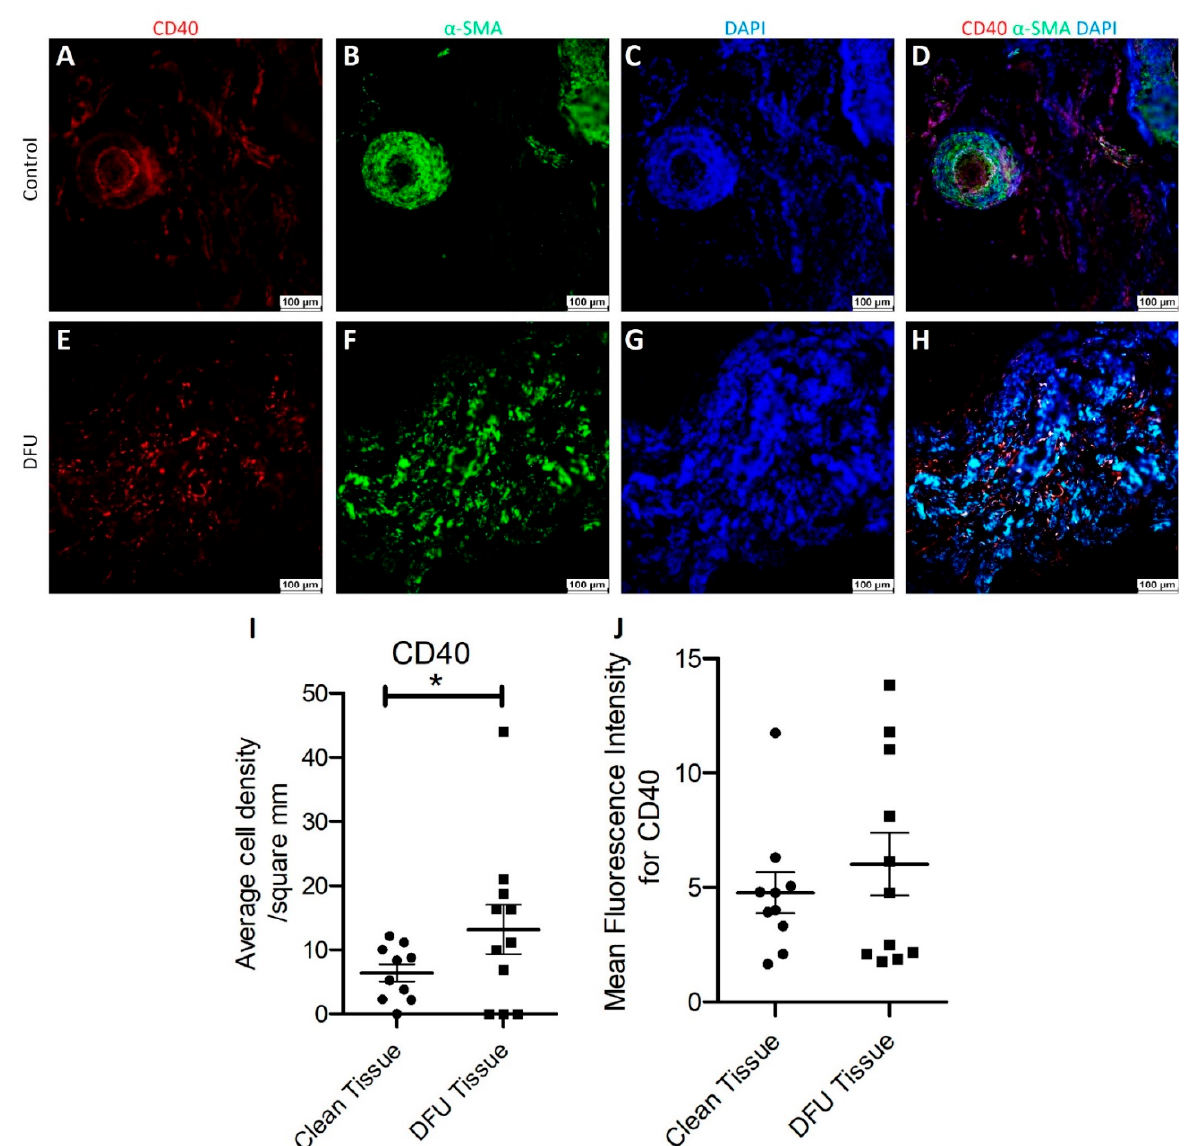
Figure 7. Dual immunofluorescence for alpha-smooth muscle actin ( α -SMA) and CD40 in clean and diabetic foot ulcer (DFU) tissues. CD40 ( A , E ), α -SMA ( B , F ), DAPI ( C , G ), merged images ( D , H ), average cell density/mm 2 ( I ), and mean fluorescence intensity for CD40 ( J ). All data are presented as mean ± SEM ( n = 11 in each group). * p < 0.05.